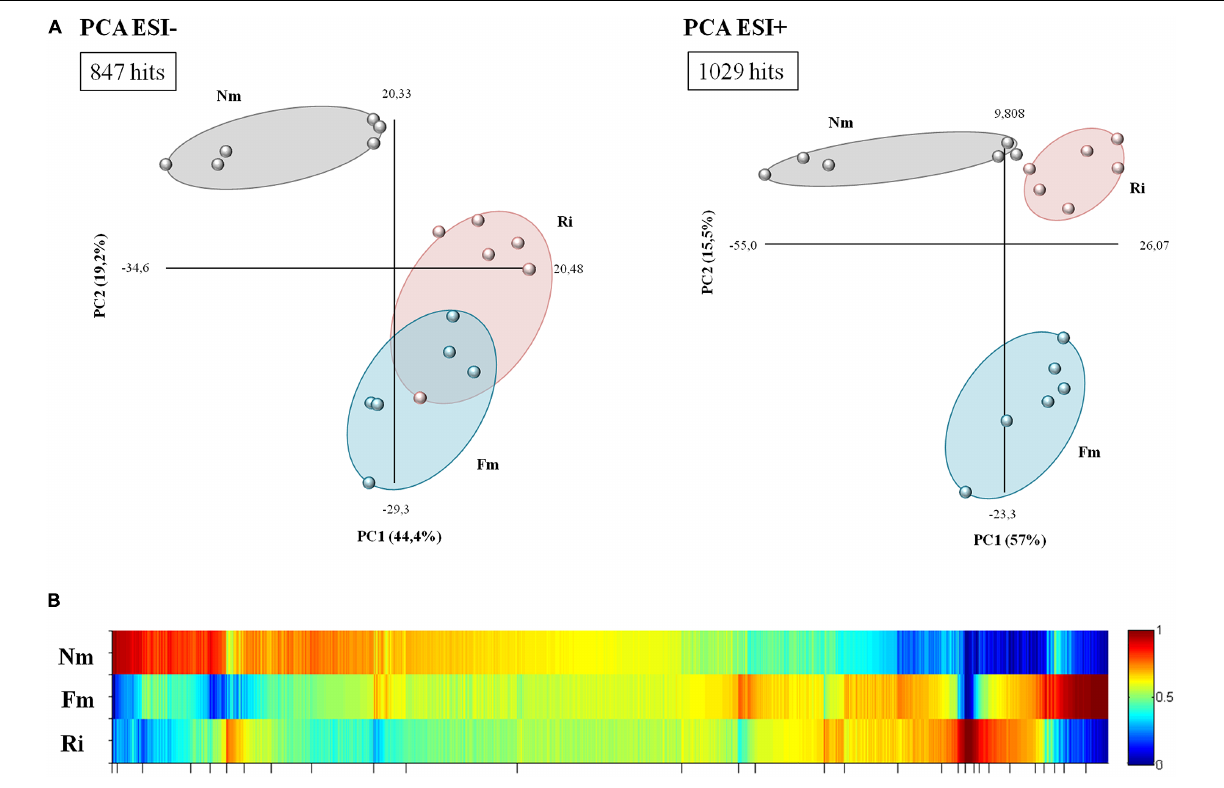
supervised analysis. (B) Heat map of the metabolite profiling, generated with MarVis Filter and Cluster packages, following a Kruskal–Wallys test ( p < 0.05) by combining positive and negative electrospray ionization analysis. Each color band represents a single compound detected in Nm, Fm, and Ri, whose accumulation is indicated for each treatment by the indicated color scale ranging from high (red) to low (blue) accumulation. The concentration of the metabolites was determined in all samples by normalizing the chromatographic pick area for each compound with the dry weight of the corresponding